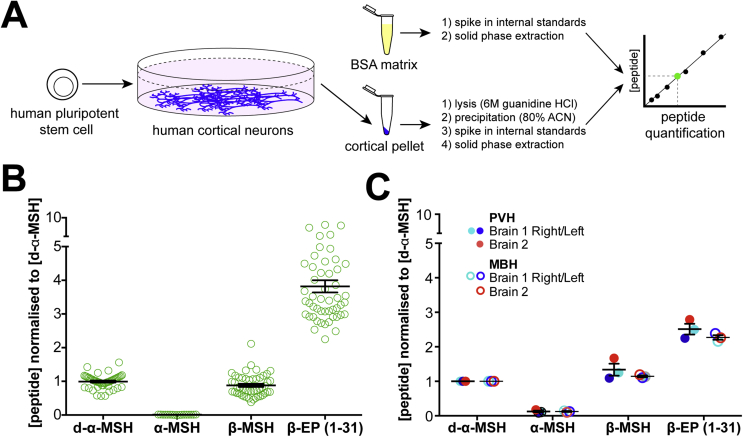
Quantification of POMC-derived peptides in hPSC-derived neurons and primary human hypothalamus. A) Schematic diagram of standard curve generation for peptide quantification. B) LC-MS/MS-based quantification of d-α-MSH, α-MSH, β-MSH and β-EP peptides in hPSC-derived POMC neurons. N = 5 independent experiments with 3–8 replicates per experiment. Concentrations were converted to molarity and then normalised to the mean concentration of d-α-MSH for each technical replicate. Error bars show SEM. C) Quantification of POMC-derived peptides in primary human brain samples. Note that while α-MSH was clearly detected in PVH Brain 1 Right and Left and MBH Brain 1 Right, the concentration was below the assay's limit of accurate quantification. N = 3 independent samples from N = 2 brains per brain region. PVH, dissected region encompassing the paraventricular hypothalamus; MBH, dissected region encompassing the mediobasal hypothalamus. Error bars show SEM.